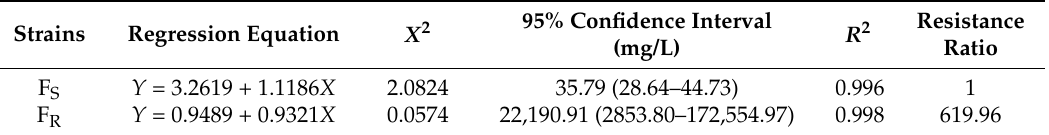
Table 1. Resistance selection of N. barkeri against fenpropathrin.